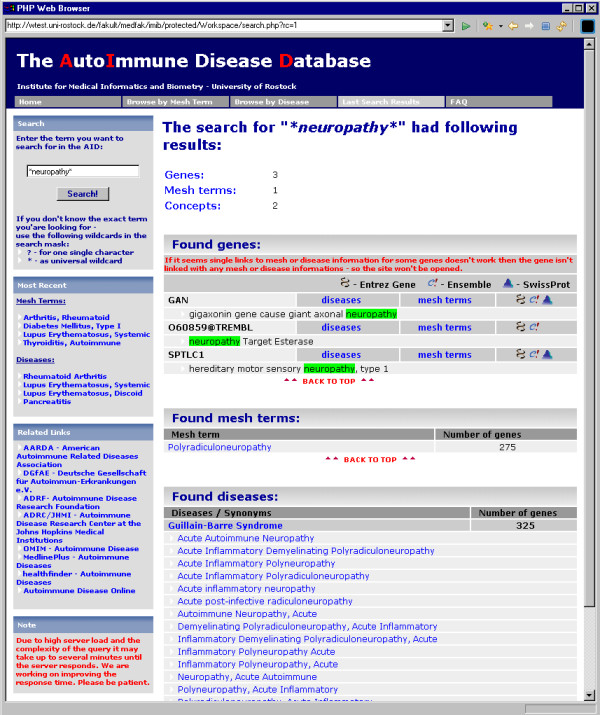
Result for the search of the string "*neuropathy*". Screen shot for the search of the string "*neuropathy*". In the first section all genes are listed that contain the search string. The search term is highlighted in green. The following two sections show the matching MeSH terms and disease concepts respectively.